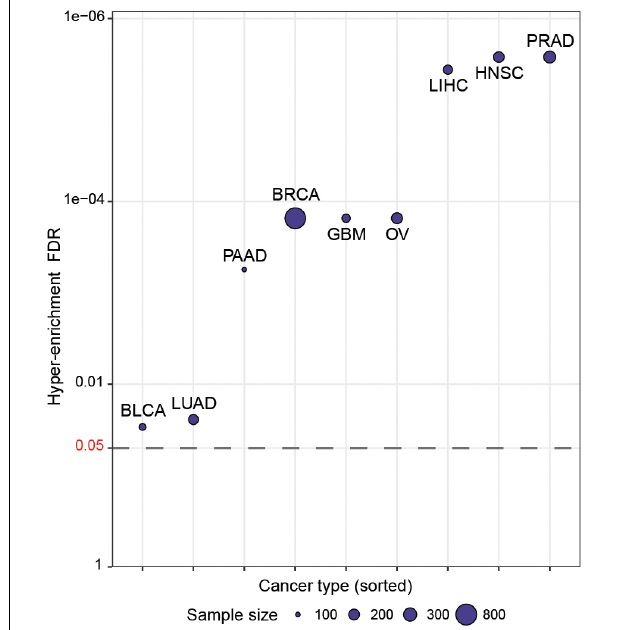
FIGURE 4 | CaDrA systematically identifies known drivers of onco-proteins and tumor suppressor proteins in human cancers. TCGA genomic data for nine different cancer types were queried using the expression of distinct proteins mapping to hallmark genes included in COSMIC ( n = 57) for sample ranking. Resulting meta-features identified by CaDrA were then pooled across all protein queries and tested for enrichment against a reference COSMIC-defined gene list ( n = 554). FDR-adjusted gene set enrichment p -values are shown, with cancer types sorted in decreasing order of FDR q -value. BLCA, bladder urothelial carcinoma; BRCA, breast invasive carcinomas; GBM, glioblastoma multiforme; HNSC, head and neck squamous cell carcinoma; LIHC, liver hepatocellular carcinoma; LUAD, lung adenocarcinoma; OV, ovarian serous cystadenocarcinoma; PAAD, pancreatic adenocarcinoma; PRAD, prostate adenocarcinoma. Points are plotted in -log 10